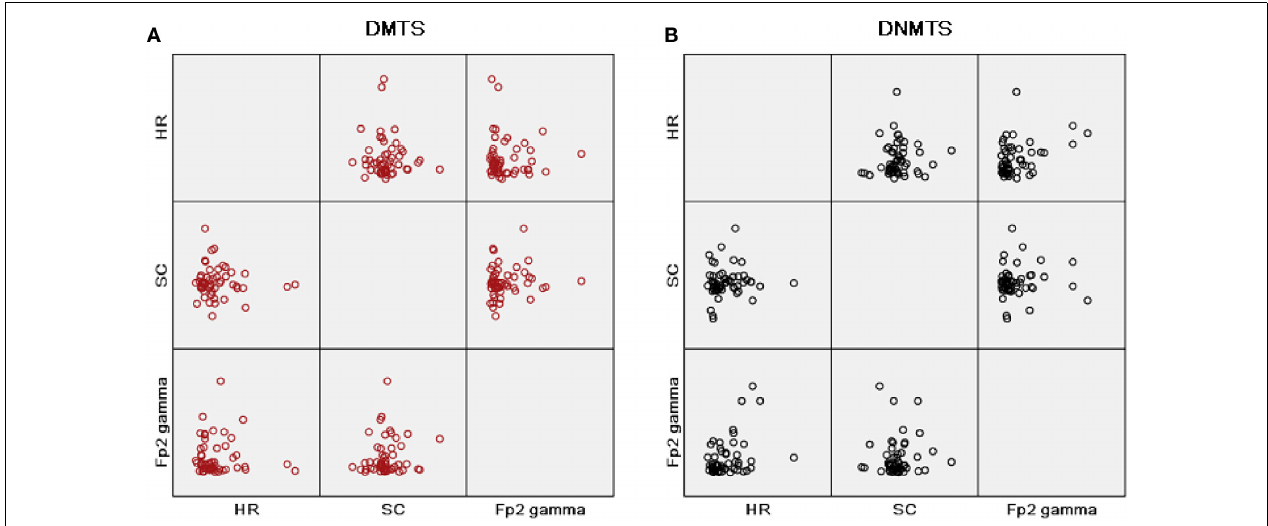
FIGURE 4 | Matrix scatter correlations, heart rate (HR) parameter with ratio of low to high frequency power (LF/HF), skin conductance mean index (SC) and gamma band power at right frontopolar location (Fp2 Gamma), in this order, in rows and columns for each condition task. (A) Condition DMTS; (B) condition